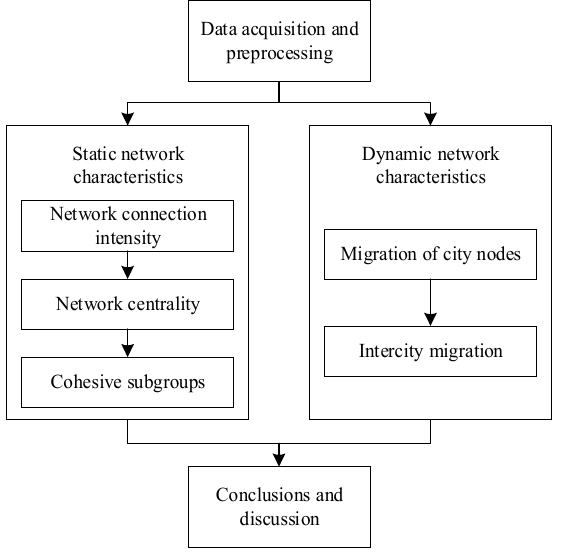
Figure 1. Work flow.